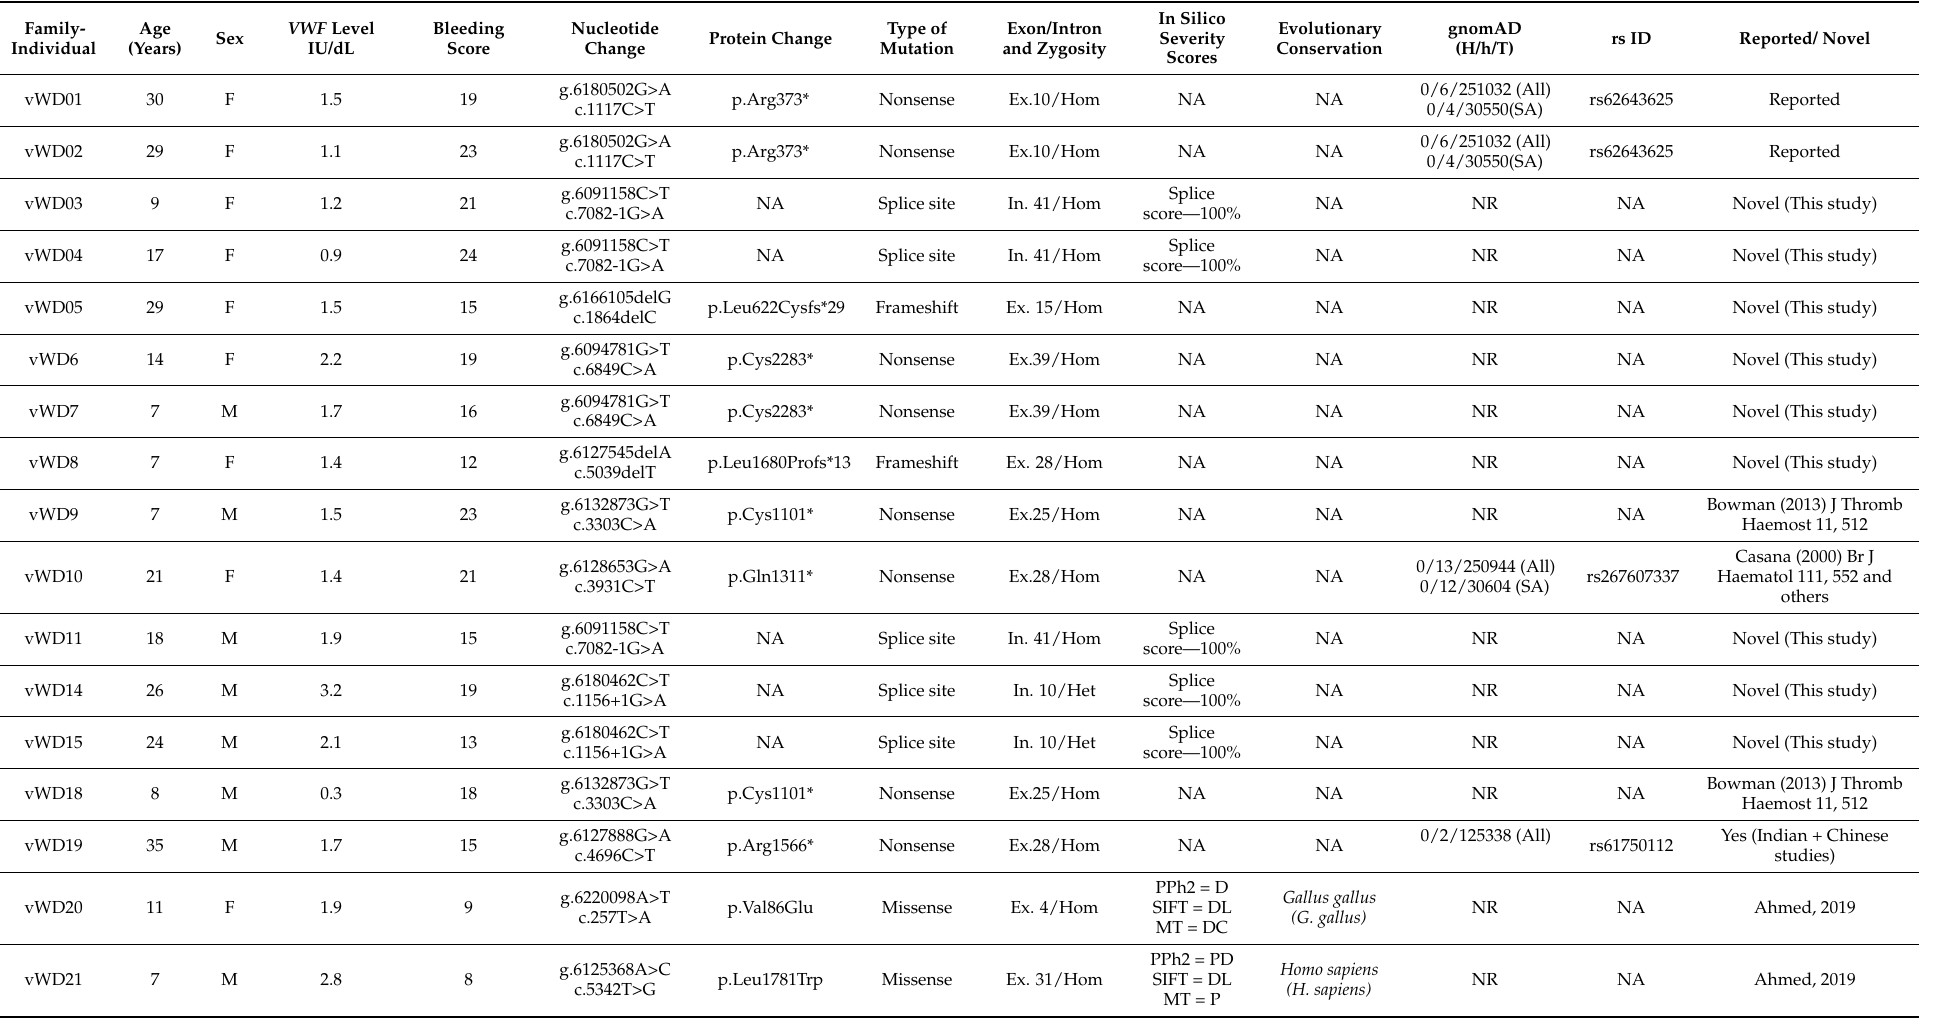
Table 1. VWF gene mutations identified in Pakistani vWD patients with type III